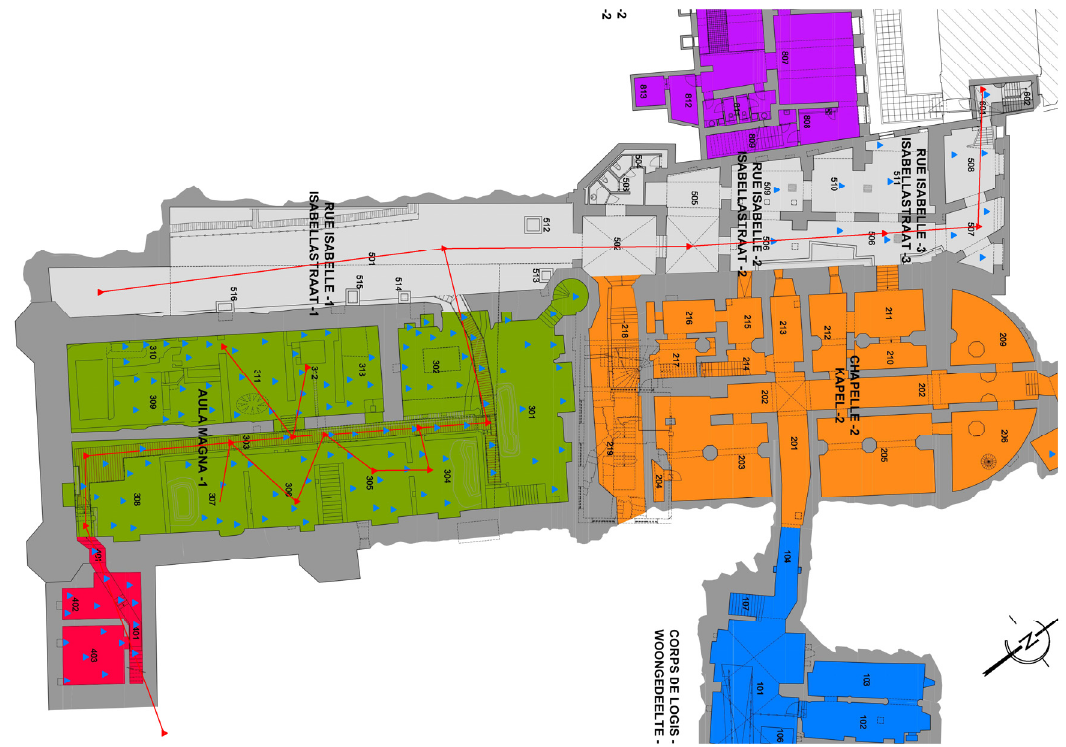
Figure 12. Surveyed areas and polygonal of the Coudenberg Museum archaeological site.